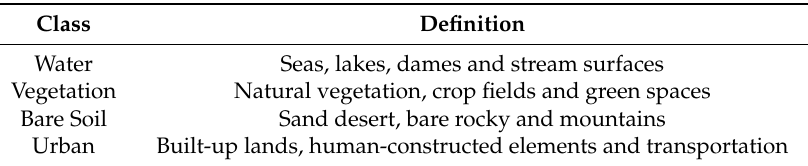
Table 3. Description of LULC